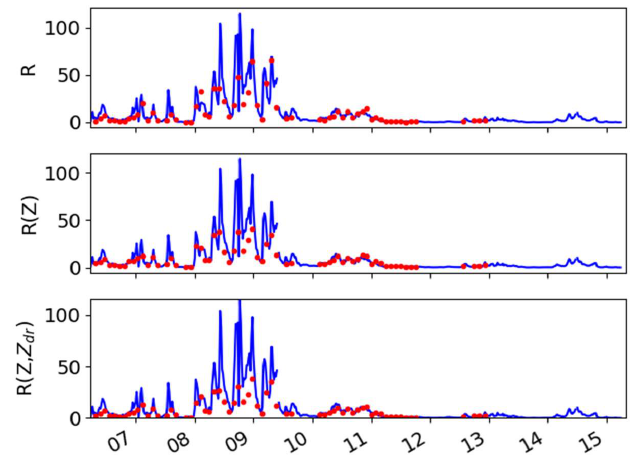
Figure 14. Same as Figure 13, but for rainfall rate retrieved by: the inverse model ( top ); R ( Z ) ( middle ); and R ( Z , Z dr ) ( bottom ).